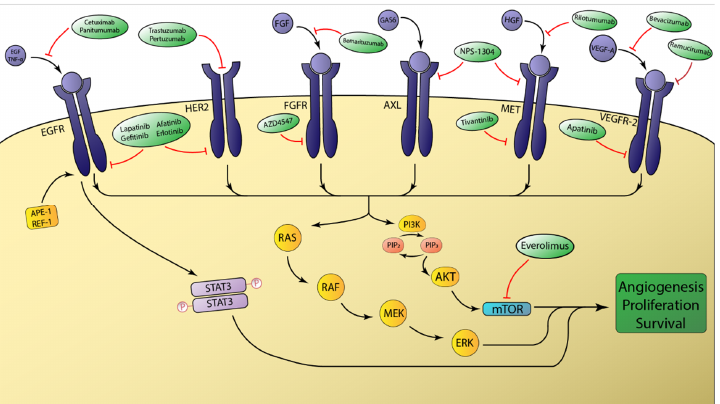
Figure 1. Schematic overview of select receptor tyrosine kinases involved in esophageal adenocarcinoma tumorigenesis. The intracellular signaling of the depicted receptor tyrosine kinases (RTKs) is primarily mediated by the RAS/RAF and PI3K/AKT pathways. Aberrant activation of these pathways ultimately favors tumor growth and survival. mTOR is a major downstream effector that is modulated by AKT signaling. Molecular therapies targeting RTKs either disrupt ligand binding or function to prevent intracellular activation of the tyrosine kinase